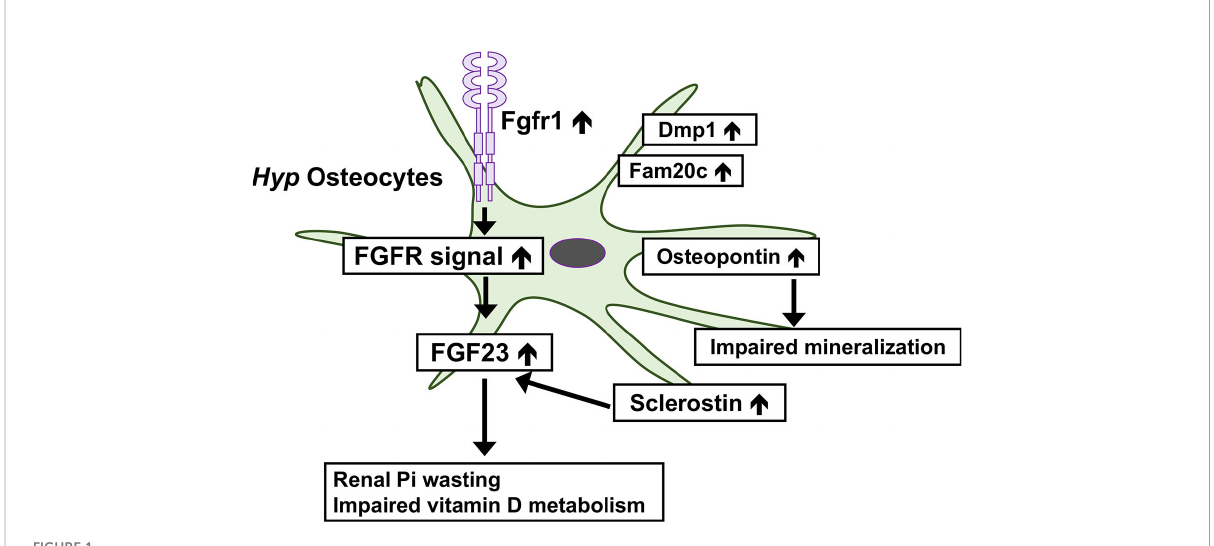
FIGURE 1 Complex abnormalities in osteocytes of Phex -de fi cient Hyp mice. In Hyp osteocytes, the expression of Fgfr1 is increased and enhanced FGFR signaling may underlie the overproduction of FGF23. The overproduction of FGF23 leads to the renal wasting of inorganic phosphate (Pi) and impaired vitamin D metabolism. Hyp osteocytes produce an increased amount of sclerostin, which may stimulate the production of FGF23. The production of osteopontin is up-regulated in Hyp osteocytes, which impairs skeletal mineralization. The expression of Dmp1 and Fam20c is also